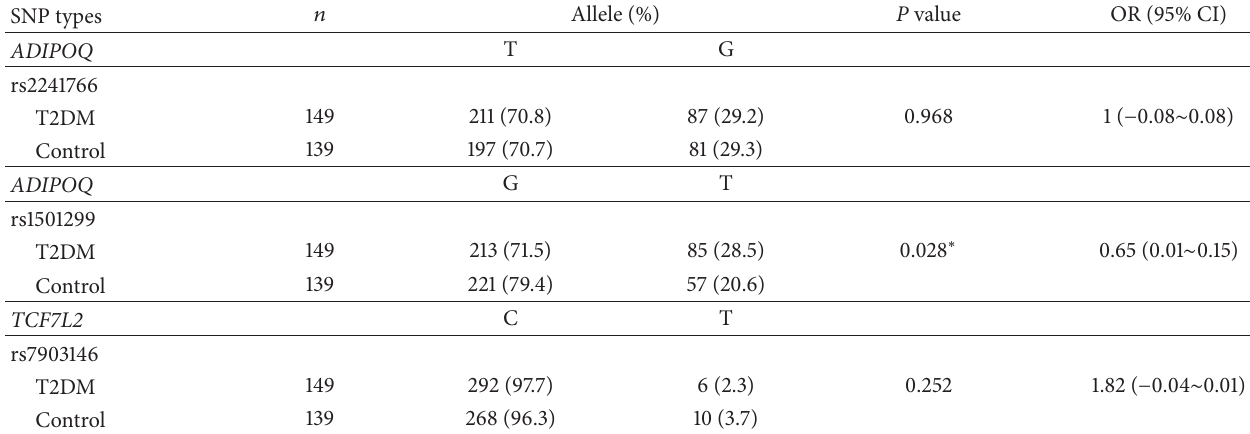
Table 5: Allele frequencies (%) of SNPs ADIPOQ and TCF7L2 : T2DM and controls.